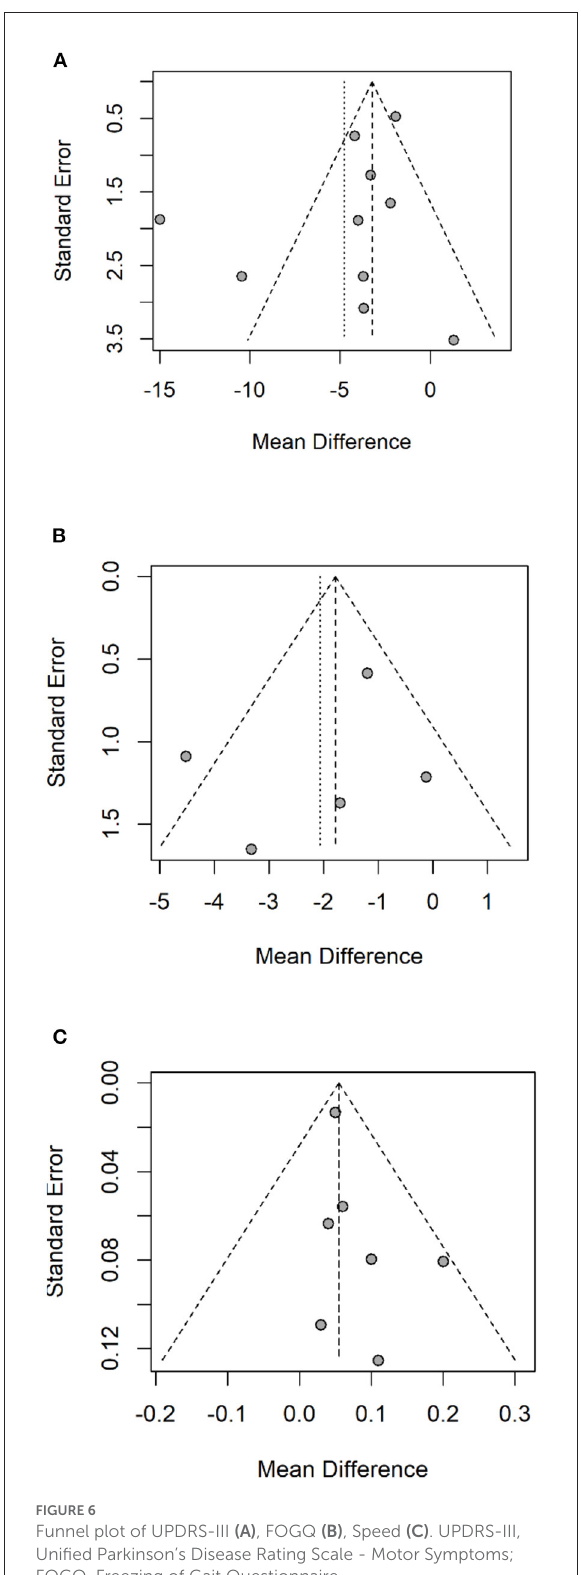
FIGURE6 Funnel plot of UPDRS-III (A) , FOGQ (B) , Speed (C) . UPDRS-III, Unified Parkinson’s Disease Rating Scale - Motor Symptoms; FOGQ, Freezing of Gait